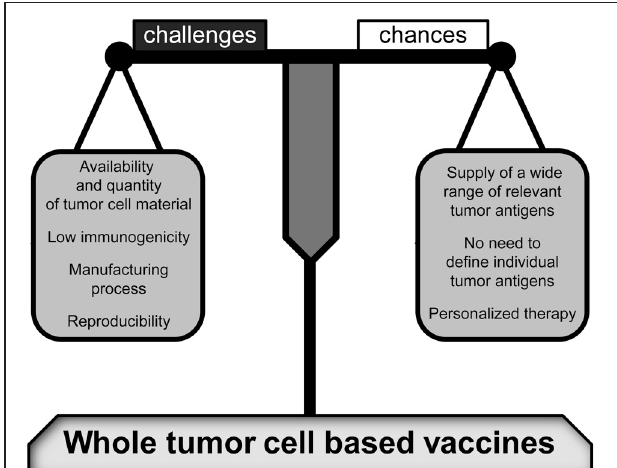
FIGURE 1 | Challenges and changes of whole tumor cell-based vaccines. As compared to peptide-based vaccines, a high variety of relevant tumor antigens is provided by whole tumor cell-based vaccines. Therefore, the tumor antigens have not to be individually defined. However, there are some crucial challenges that may decide about the vaccine’s efficiency and productivity including the immunogenic potential of tumor cell material and a reliable manufacturing process associated with a high reproducibility. Furthermore, the limited availability of tumor cell material has to be taken into account. Nevertheless, when these resolvable problems have been resolved, whole tumor cell-based vaccines will be prime immune therapies for personalized tumor